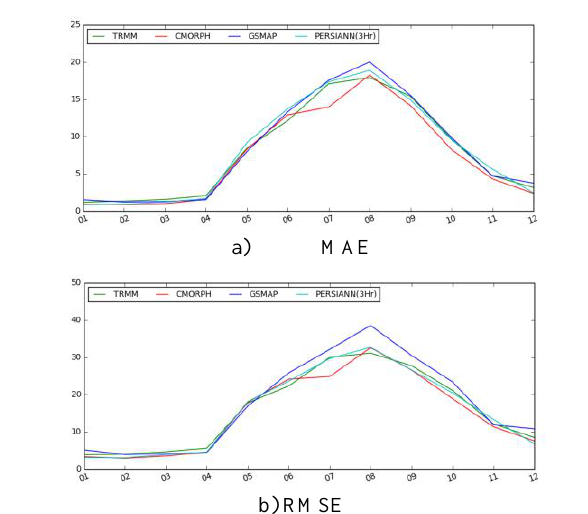
Figure 4. (a) MAE and (b) RMSE of West coast stations